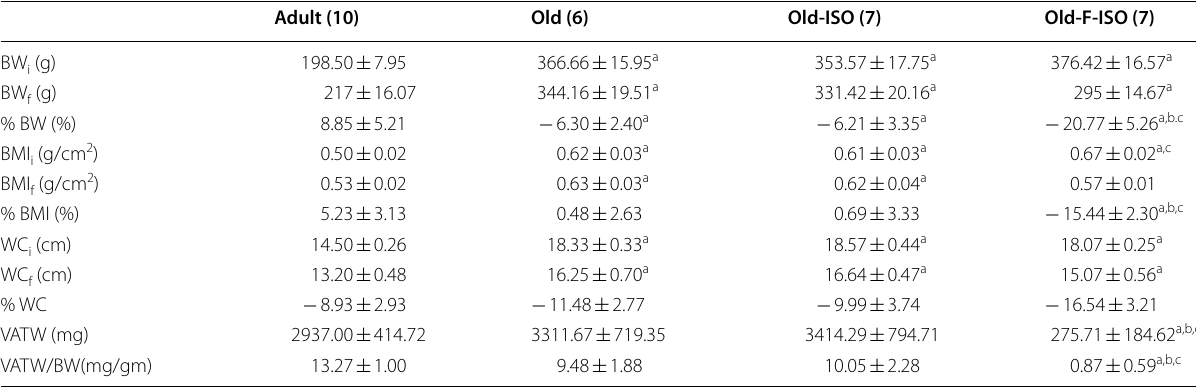
Data are expressed as mean SEM ± Number in parenthesis is the number of rats in each group i, initial; f, final; % percentage change; BW, body weight; BMI, body mass index; WC, waist circumference; VTW, visceral tissue weight; VTW/BW; visceral tissue weight/body weight; FPG, fasting plasma glucose; FI, fasting insulin; HOMA-IR, homeostatic model assessment of insulin resistance; HOMA-%B, homeostatic model assessment of beta cell function a Significance of difference from adult group by LSD test at P < 0.05 b Significance of difference from old group by LSD test at P < 0.05 c Significance of difference from old-ISO group by LSD test at P <